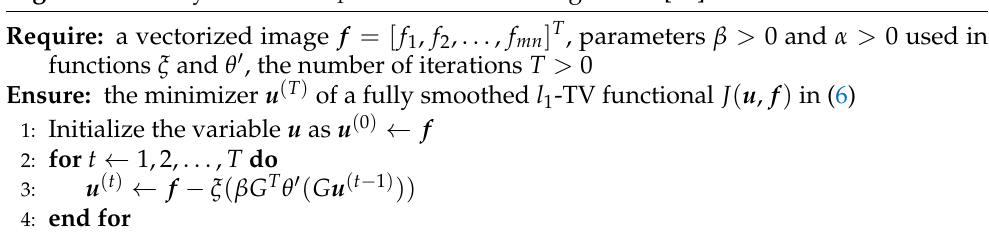
Algorithm 1 Fully smoothed l 1 -TV minimization algorithm